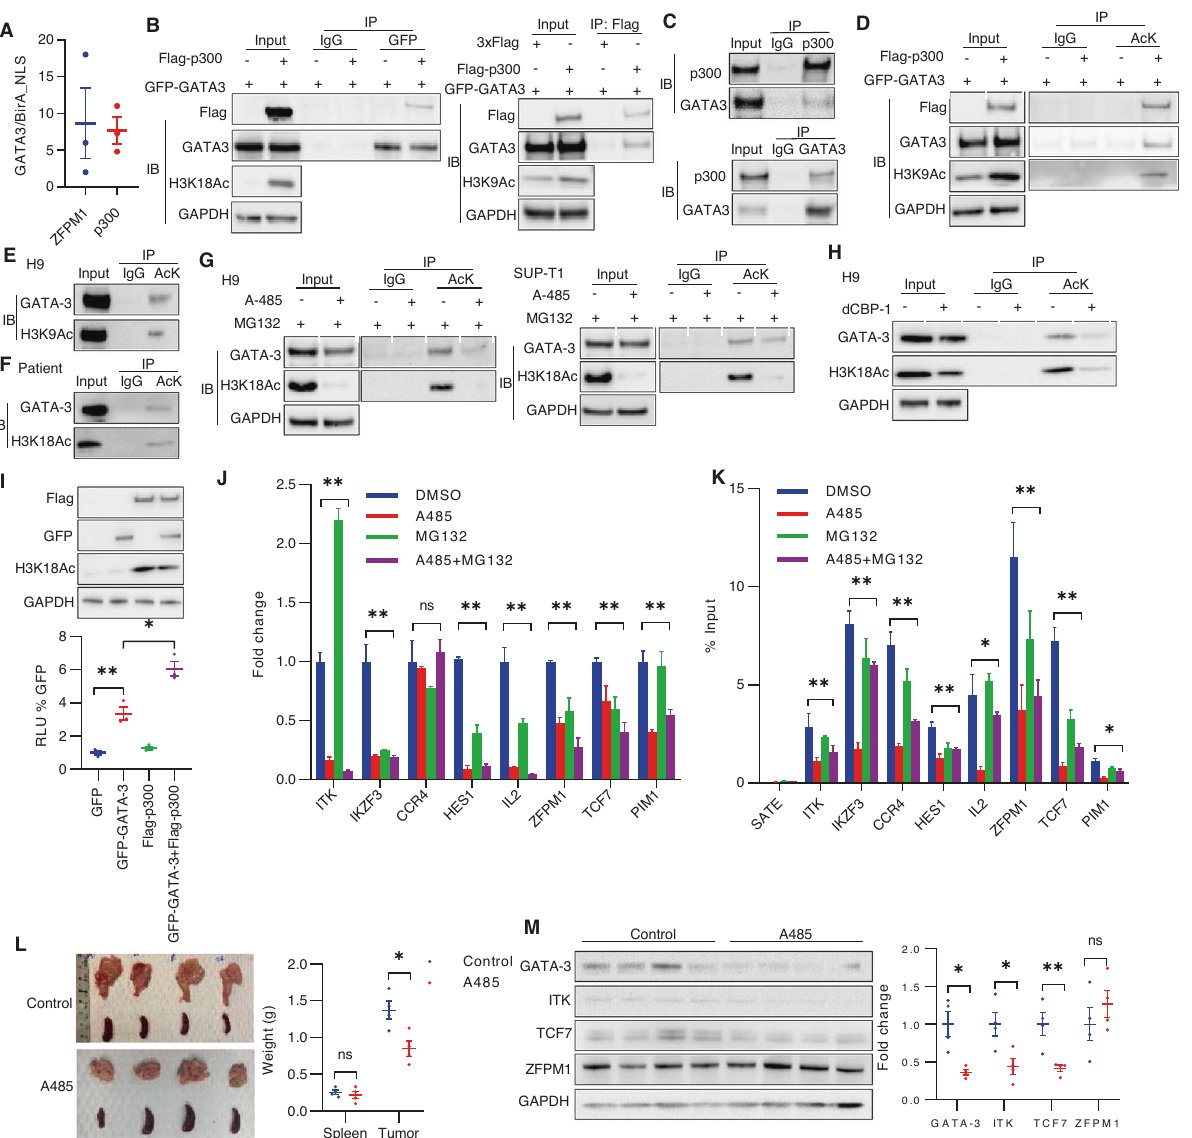
Fig. 5 p300 interacts with and acetylates GATA-3. A Bio-ID identi fi ed P300 and ZFPM1 as GATA-3 binding partners. The ratio of biotinylated P300 and ZFPM1 peptides identi fi ed in GATA-3-BirA and control BirA-NLS transduced Jurkat cells is shown on the y-axis. B GFP-tagged GATA-3 and Flag-tagged P300 are expressed in HEK293T cells. Anti-GFP (or isotype control) immunoprecipitation (IP) is performed, and cell lysates immunoblotted (IB) for P300 (Flag) and GATA-3 (GFP), as indicated. H3K18 acetylation, as a surrogate for P300 acetyltransferase activity, was examined in the input, as indicated. C Endogenous GATA-3 and P300 are co-immunoprecipitated, as indicated, in H9 cells. D HEK293T cells transfected with GFP-tagged GATA-3 and Flag-tagged P300 are utilized and acetylated proteins immunoprecipitated, and GATA-3 identi fi ed